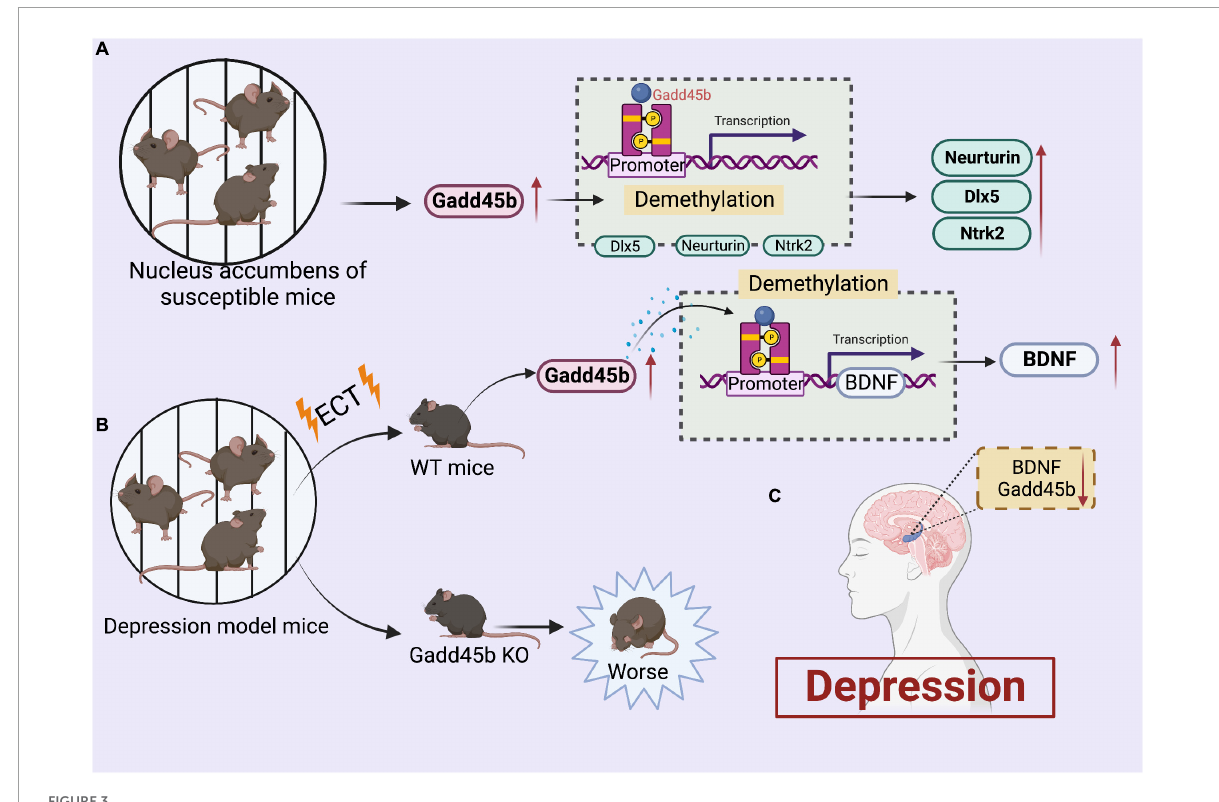
FIGURE3 Roles of growth arrest and DNA damage-inducible beta (Gadd45b) in depression. (A) Increased gadd45b expression in the brain of nucleus accumbens of susceptible mice alters the demethylation of Neurturin, Dlx5, and Ntrk2, resulting in increased Neurturin, Dlx5, and Ntrk2 performance. (B) Increased gadd45b expression in the brains of depressed mice after ect therapy boosts BDNF function by modifying BDNF demethylation. (C) Decreased Gadd45b, BDNF expression in the brain of patients with depression (Figure was created with